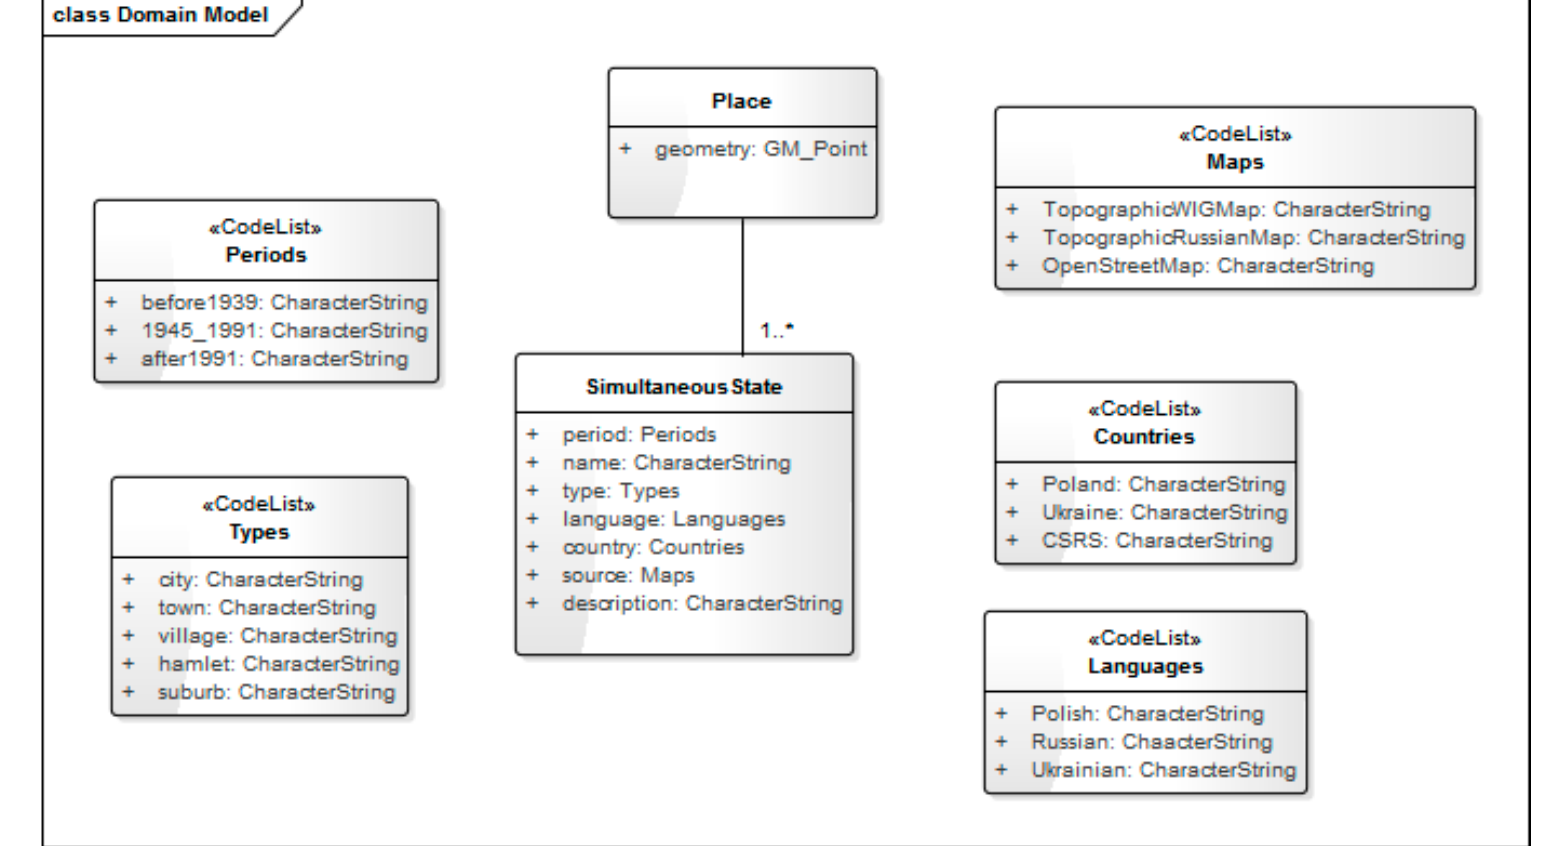
Figure 6. An UML (Unified Modeling Language) class diagram describing the concept of spatio-temporal database structure (source: own study).